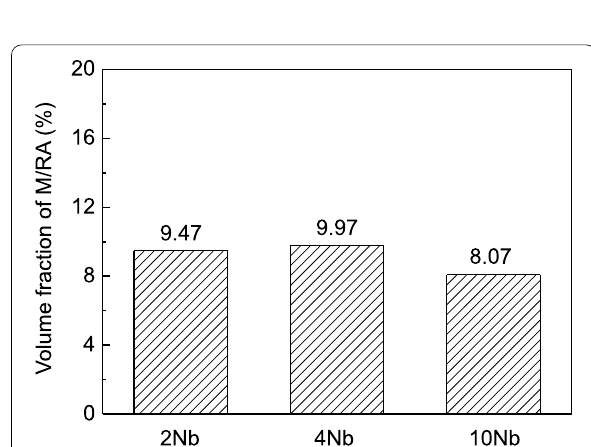
Fig. 13 Results of M/RA volume fraction based on different Nb contents (wt.%)